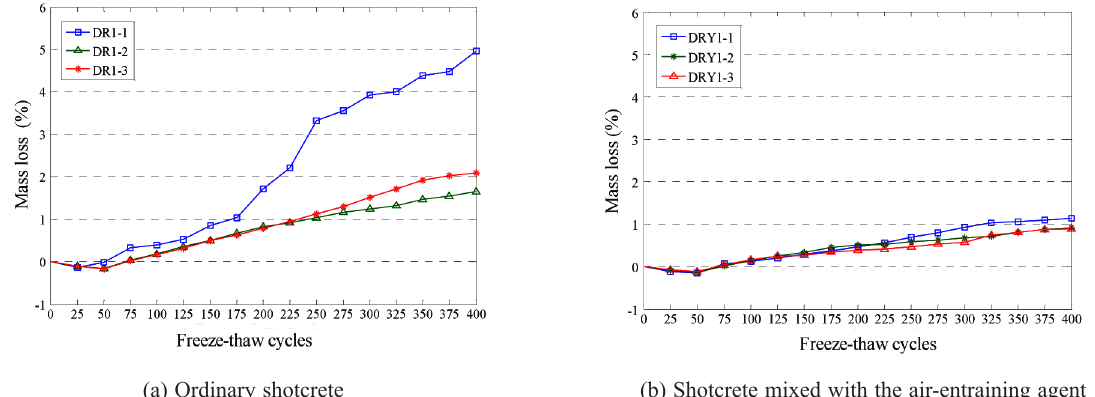
(a) Ordinary shotcrete (b) Shotcrete mixed with the air-entraining agent Fig. 4. Change in mass loss of the shotcrete specimens during the freeze-thaw cycles